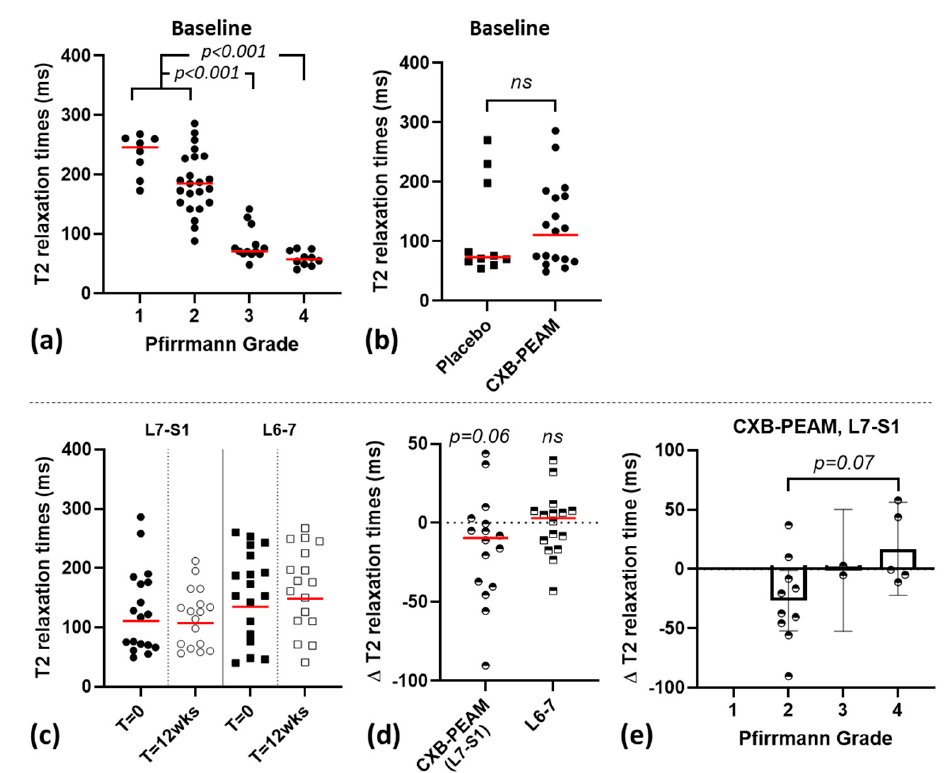
Figure 2. Quantitative MRI (T2 relaxation times) in 30 dogs suffering from degenerative lumbosacral stenosis, treated with intradiscal injection with celecoxib (CXB)-polyesteramide microspheres (PEAMs). ( a ) T2 relaxation time for L6-L7 and L7-S1 intervertebral discs (IVD) in relation to Pfirrmann grading at baseline. Pfirrmann grade 1 and 2 IVDs had significantly higher T2 relaxation times compared to grade 3 and 4 IVDs. ( b ) T2 relaxation time at baseline did not differ between placebo vs. CXB-PEAM-treated group. Total ( c ) and change ( ∆ ; d ) in T2 relaxation time for L7-S1 and L6-L7 IVDs at T = 0 weeks and T = 12 weeks within the CXB-PEAM-treated group; T2 relaxation